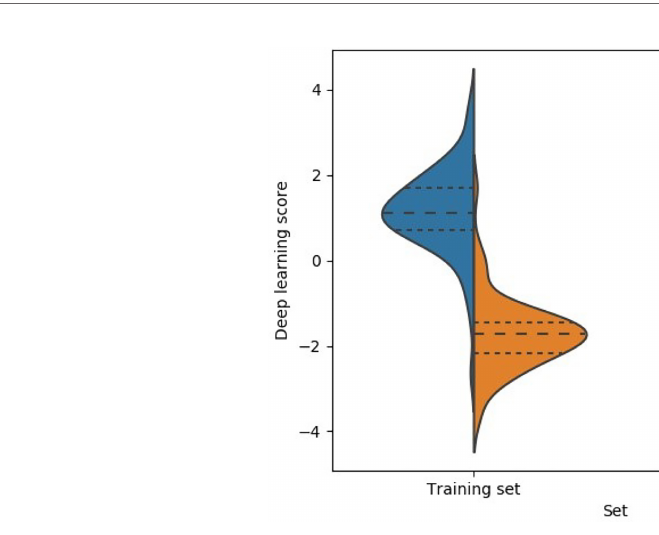
FIGURE 3 | Deep learning model score HER2 classi fi